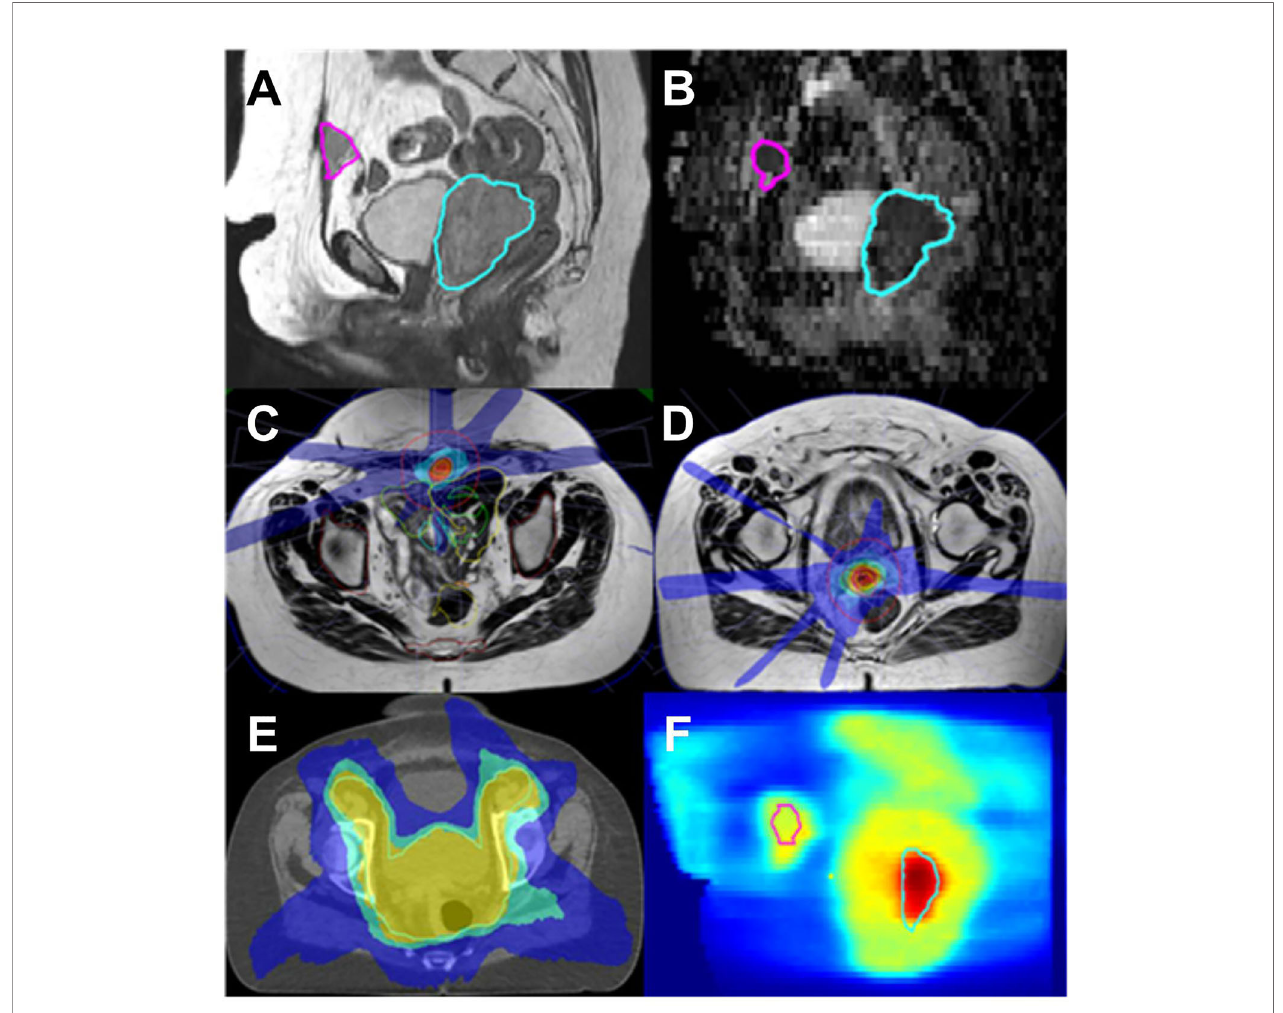
FIGURE 4 | Endometrial cancer; MR Linac SBRT for concurrent vaginal vault recurrence and anterior abdominal wall metastasis. (A) : T2 sagittal (B) : ADC map derived from diffusion weighted acquired with MR Linac. Abdominal metastasis in pink and vaginal vault recurrence in blue. Target and OAR are clearly visualized on the MR images allowing for daily adaptation. (C, D) : Typical daily MR Linac plans for both lesions (isodoses red 110%, orange 100%, blue 25%). (E) : elective EBRT plan on planning CT (yellow 95%, green 82%, blue 52%) (F) : overlay of elective and boost plans (range 0 – 70 Gy physical dose).